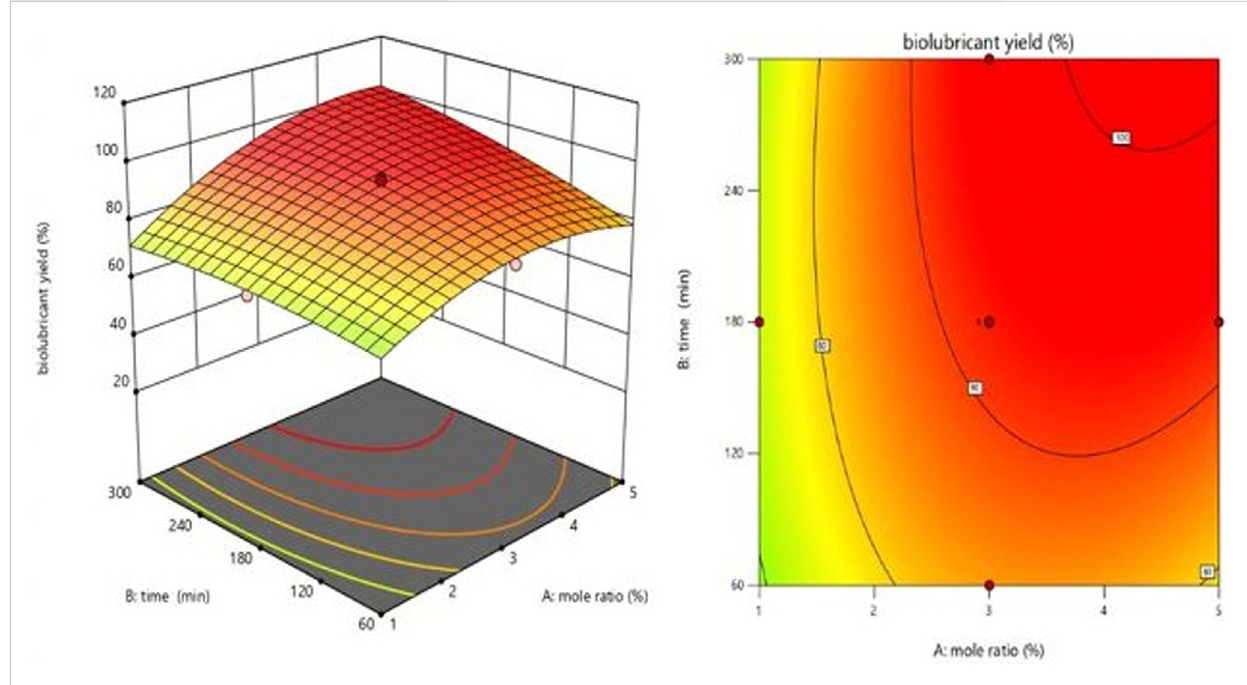
FIGURE 5 Effect of the interaction of time and mole ratio (EG-TO-FAME) on biolubricant yield.